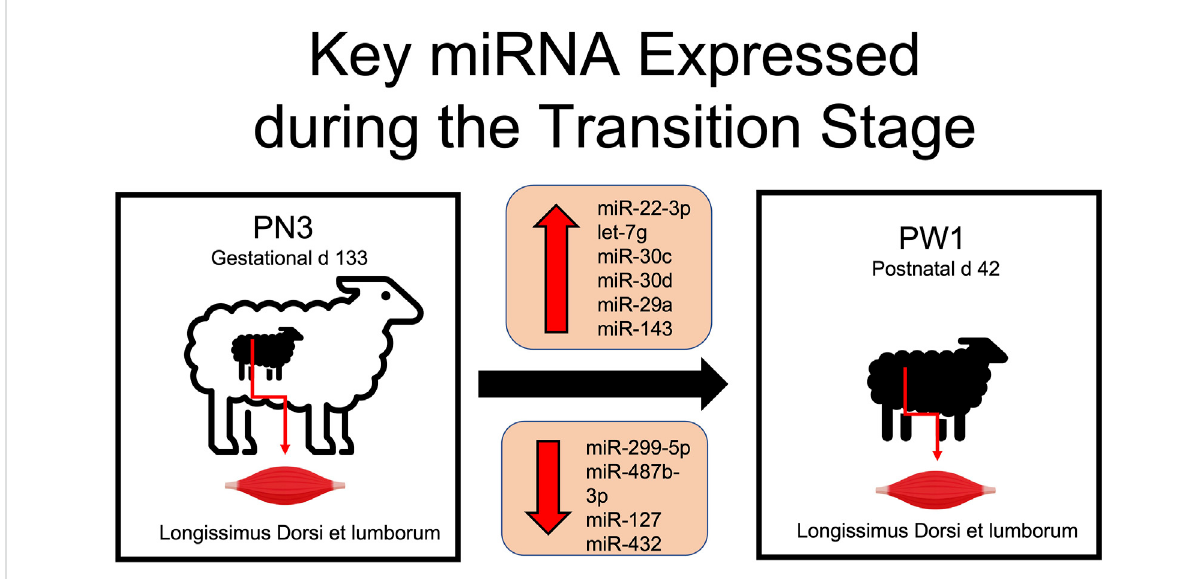
FIGURE 5 Differentially expressed miRNA involved in skeletal muscle hypertrophy during the transition from prenatal to postnatal